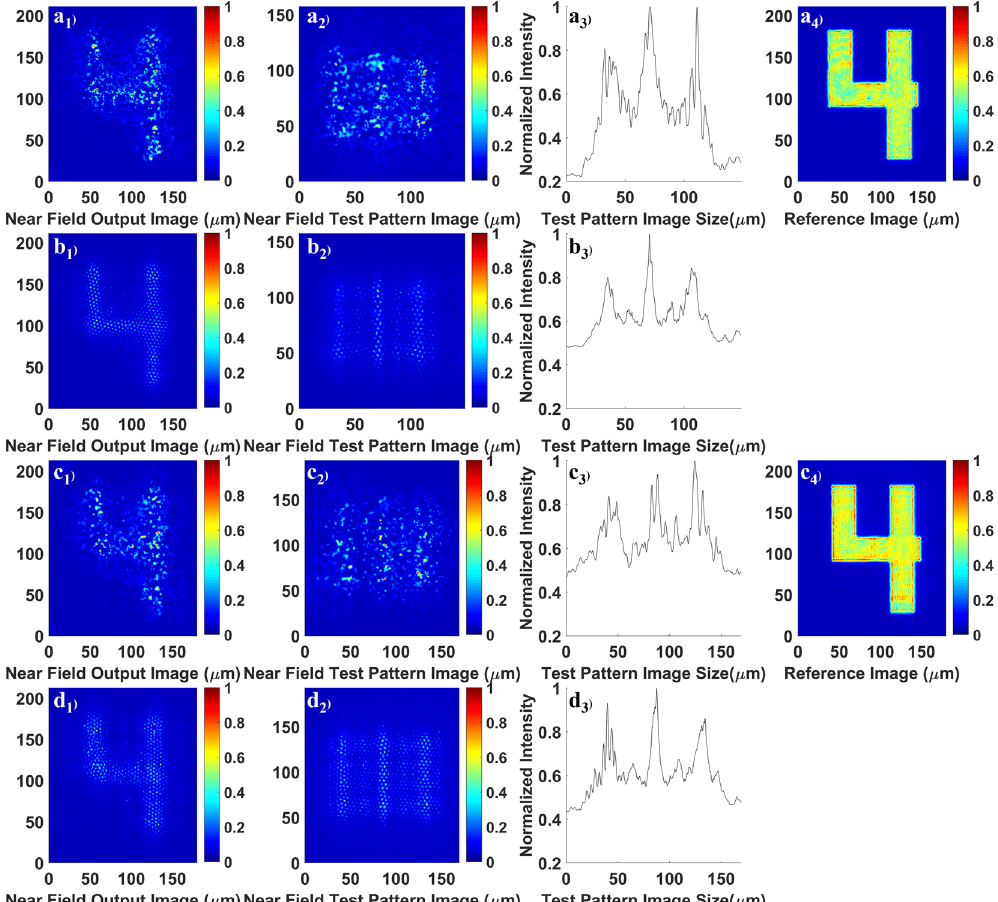
Figure 3. ( a1 – a3 ) and ( c1 – c3 ) are images of numbers and line elements and the corresponding intensity cross-sections of the line elements after transport through 4.5 cm of GARF(1). The integrated cross-sections are obtained by integration over the vertical axis of line elements. The reference images ( a4 ) and ( c4 ) are measured without any fiber; ( b1 – b3 ) and ( d1 – d3 ) are images of numbers and line elements and the corresponding intensity profiles of the line elements after transport through 4.5 cm of commercial imaging fiber FIGH- 10–500N. The wavelength for a1)-a4) and b1)-b3) is 405 nm while the wavelength for ( c1 – c4 ) and ( d1 – d3 ) is 635 nm. The number “4” belongs to group 3 on the resolution test target. The line elements in ( a2 ) and ( b2 ) belong to group 4 number 6 on the resolution test target, and ( c2 ) and ( d2 ) belong to group 4 number 4. The visibility values (I max − I min )/(I max + I min ) are 0.31 for ( a3 ), 0.24 for ( b3 ), 0.28 for ( c3 ), and 0.28 for ( d3 ), respectively. To calculate visibilities, the maximum values are calculated using the average of all three peaks and the minimum values are obtained using the average of the two valleys between the